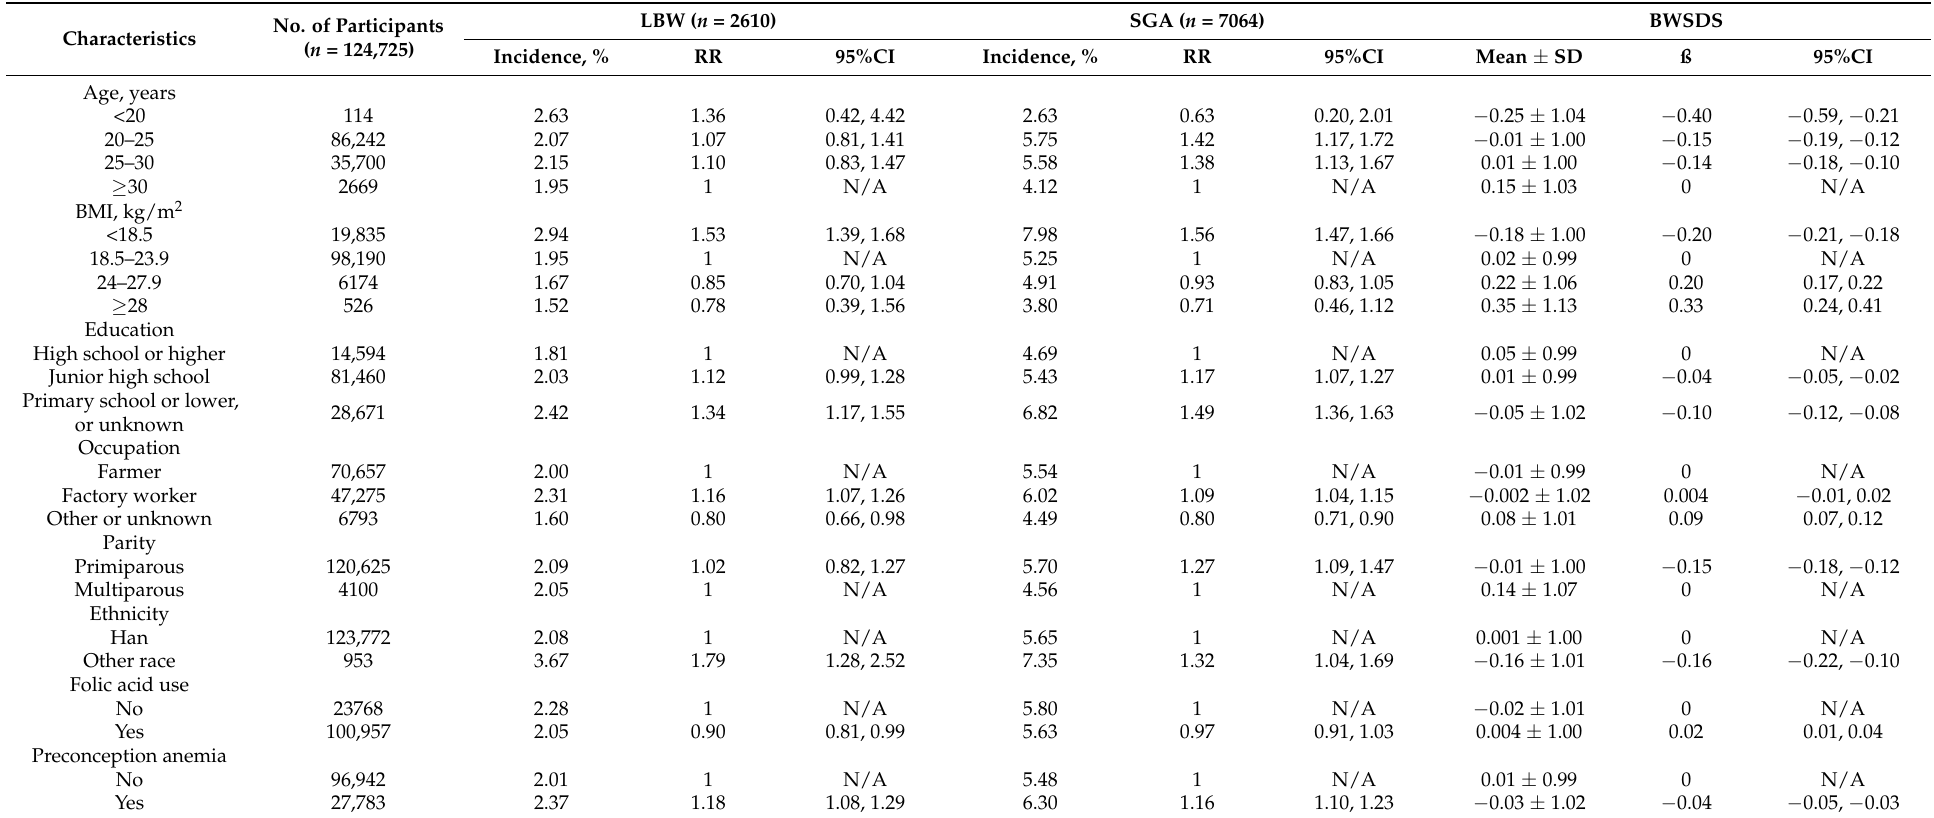
Table 2. Incidences and crude RR of LBW and SGA according to preconception anemia and other women’s characteristics, China,